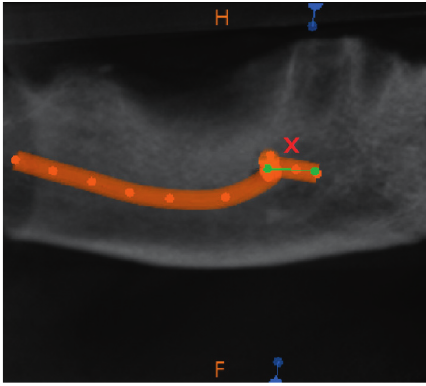
Figure 1: CBCT image showing anterior extension of alveolar nerve loop.